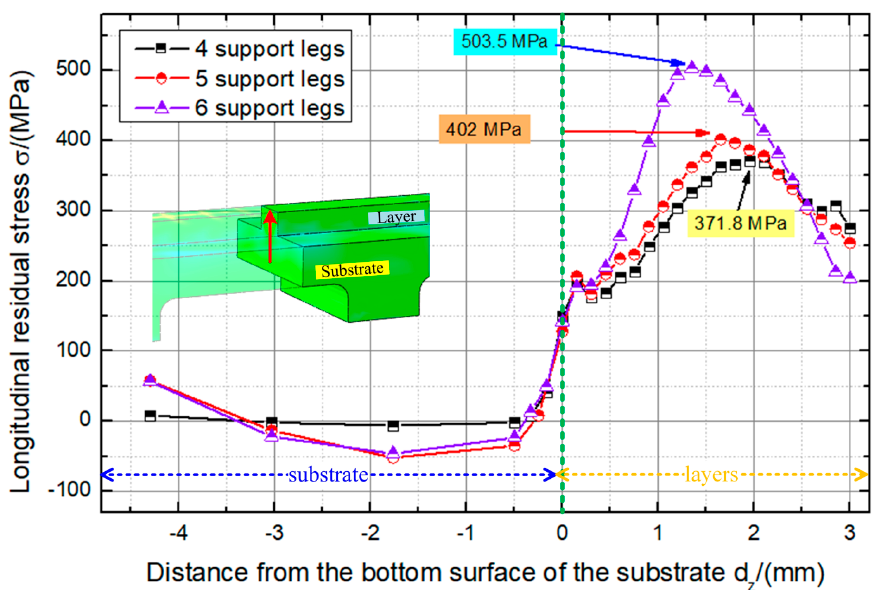
Figure 14. Longitudinal residual stresses of the reduced-thickness section with different numbers of support legs.